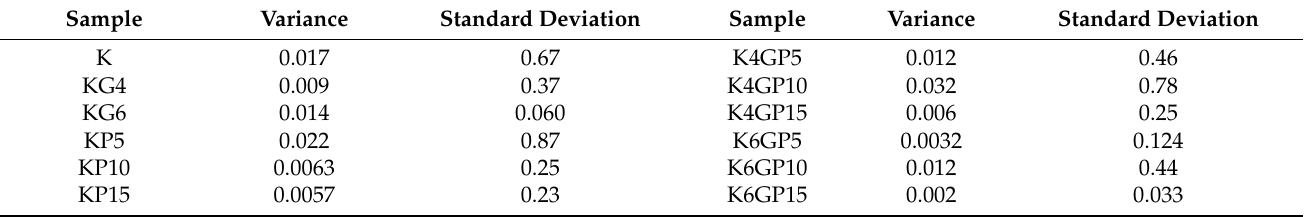
Table 3. Summary of variance and standard deviation of the specimen of shear strength on the 1st